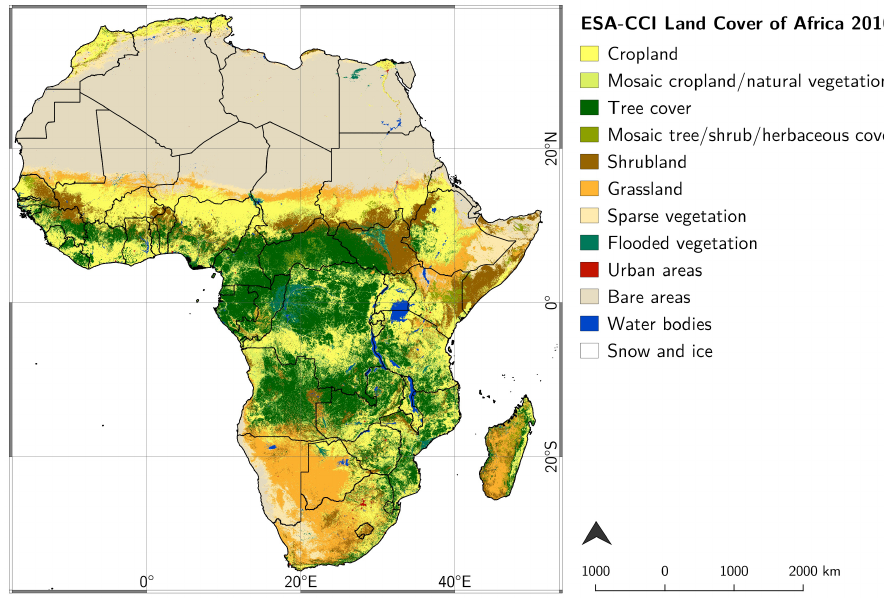
Figure 1. Land cover of Africa for 2008–2012, data source: